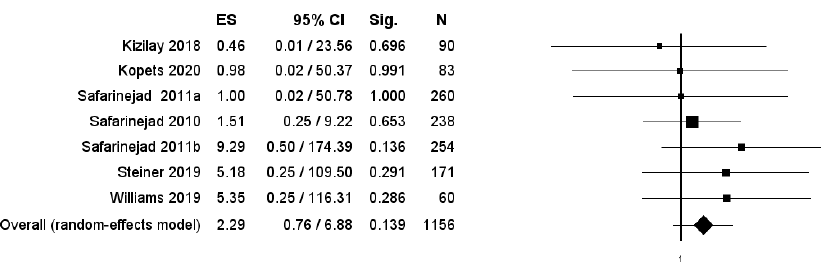
Figure 10. Forest plot showing the OR for treatment discontinuation due to adverse events. ES: effect size; CI, confidence interval. (I2 = 0.00, p = 0.853).